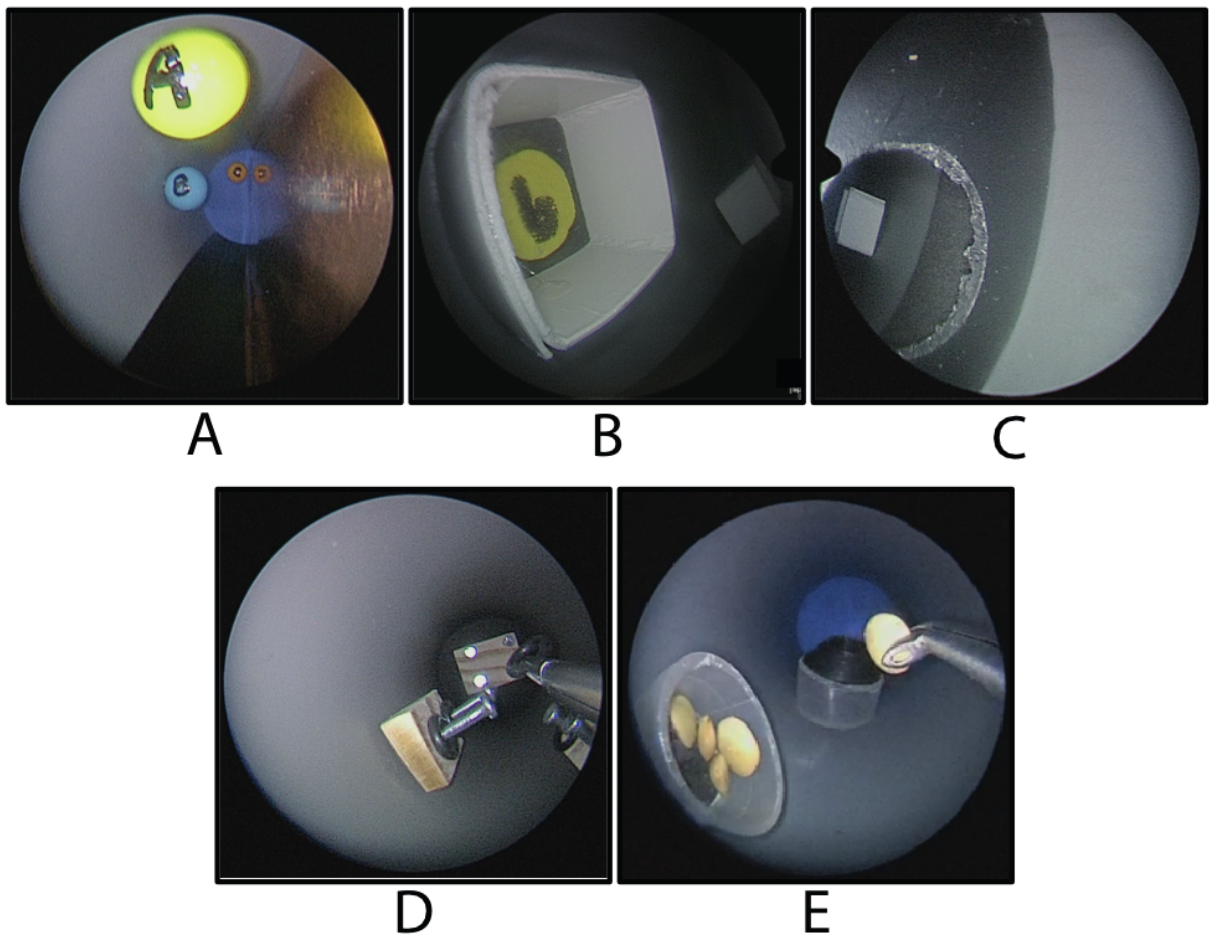
Figure 2. Endoscopic view during tasks performance: A) Focus with 0º scope, B) 45º scope and C) 45º scope & obstacles; D) transference of rings, and E) lentils with 0º